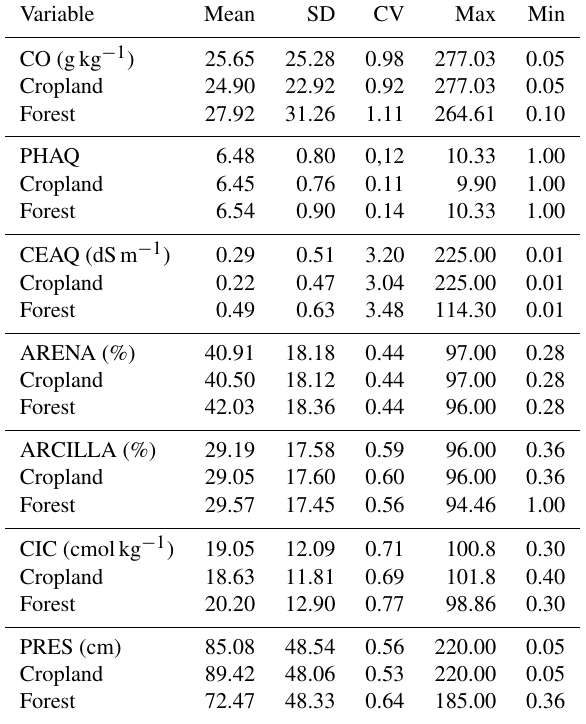
The abbreviations used in the table are as follows: CO – organic carbon, PHAQ – pH H 2 O, CEAQ – electric conductivity in water, ARENA – sand total, ARCILLA – clay total, CIC – cation exchange capacity, and PRES – effective depth. SD denotes standard deviation, and CV is the coefficient of